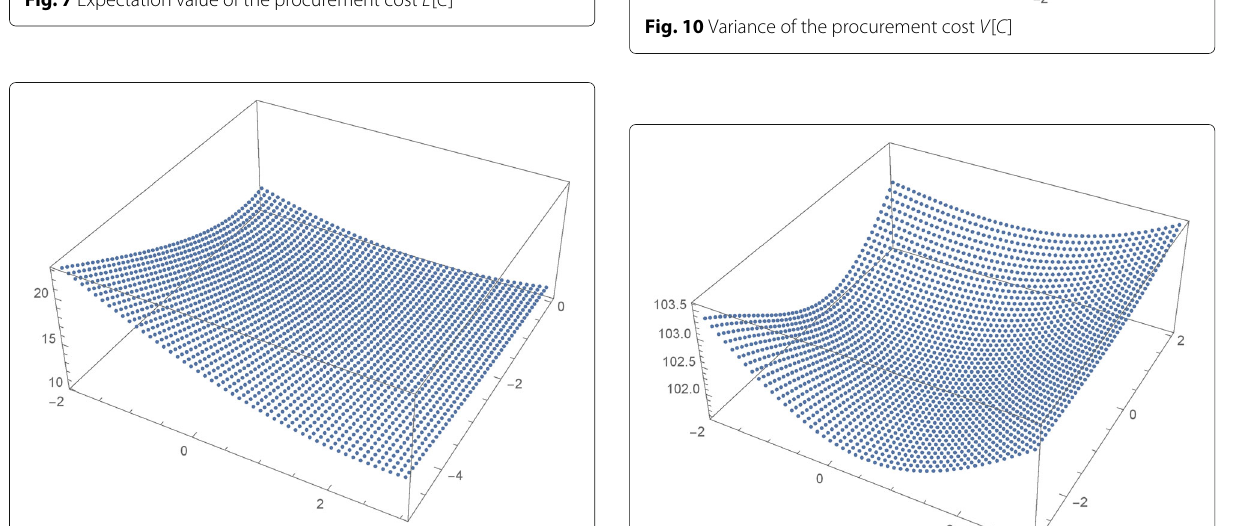
Fig. 7 Expectation value of the procurement cost E [ C ]